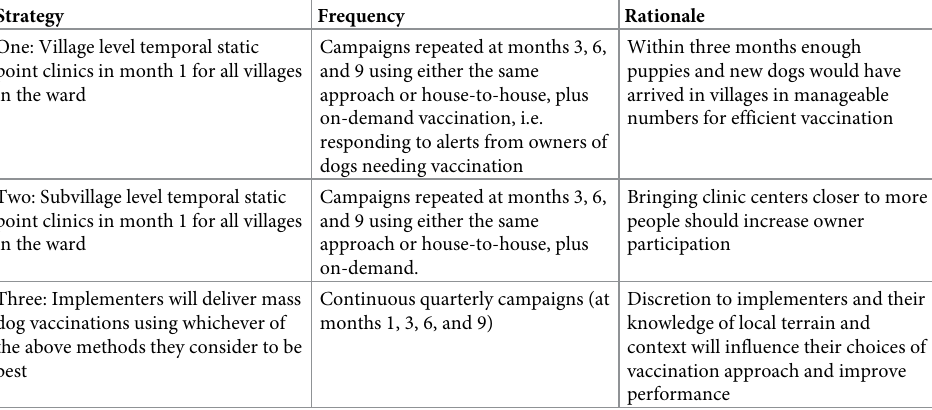
Table 4. Strategies for delivering components of CBC-MDV in the pilot